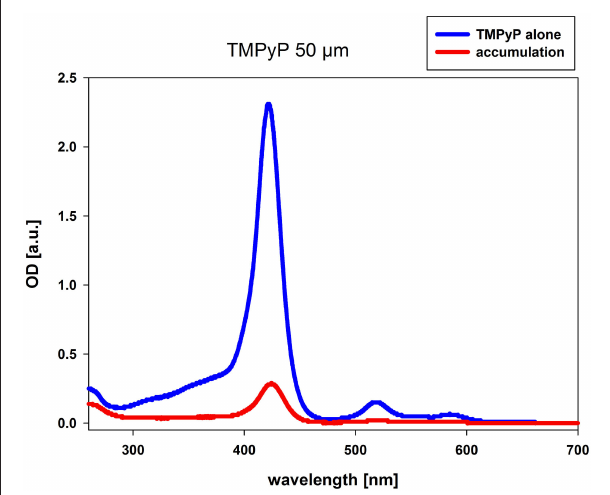
FIGURE 2 | Accumulation of TMPyP in C. albicans . C. albicans was incubated with 50 µ M TMPyP for 15min in the dark. The sample was centrifuged and the OD of the supernatant was determined by using a spectral photometer. The supernatant of the sample was diluted in Millipore water using a dilution factor of 1:5 before spectral analysis. We compared the obtained spectrum (red line, accumulation) to the spectrum of TMPyP alone (blue line). The difference in the OD values refers to the amount of PS that has been resorbed or attached by C. albicans .